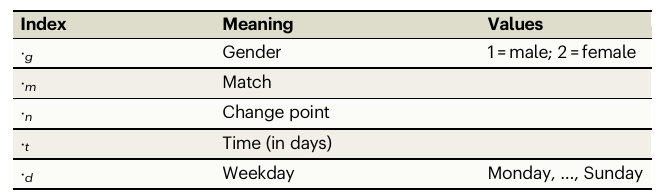
Table 3 | Indices Table 4 | Country-dependent priors on the delay